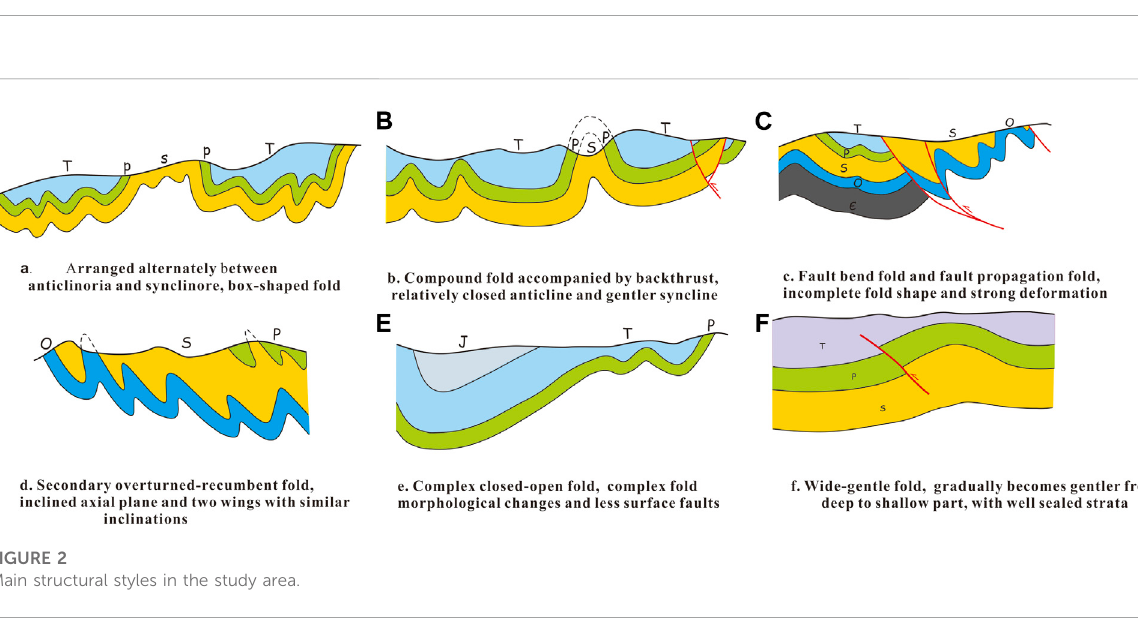
FIGURE 1 Geologicalstructureofthestudyarea.F 1 ,Hongchunba − Zengjiabafault;F 2 ,Chengkoufault;F 3 ,Wupingfault;F 4 ,Wanyuan − Wuxifault;F 5 ,Shashi hidden fault; F 6 , Qiyaoshan basement fault; Ⅰ 1 , southern Dabashan linear synclinore − epimetamorphic belt; Ⅰ 2 , northern Dabashan dome-shaped anticlinoria − hypometamorphicbelt; Ⅱ 1 ,southernDabashanimbricatefaultbelt; Ⅱ 2 ,southernDabashanrampfoldbelt; Ⅱ 3 ,southernDabashanfrontal fold belt; Ⅲ 1 , high-angle fold belt of eastern Sichuan Basin; Ⅳ 1 , Qiyaoshan depression and fold belt.